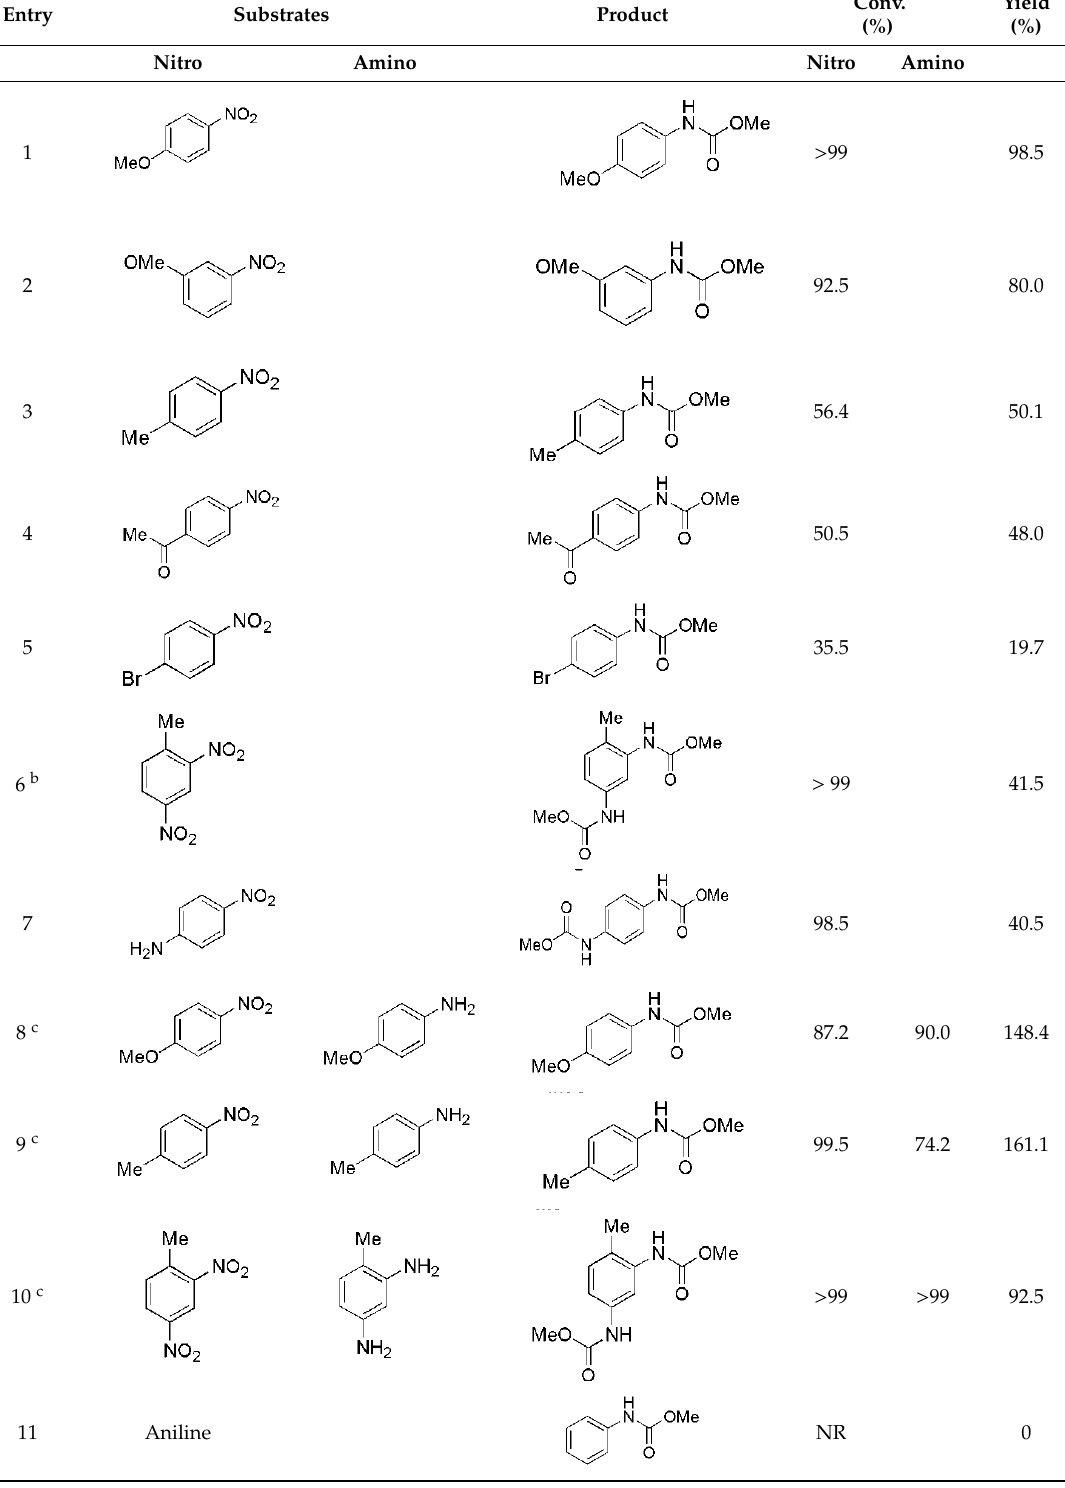
Table 4. Reductive carbonylation of various nitro compounds a .